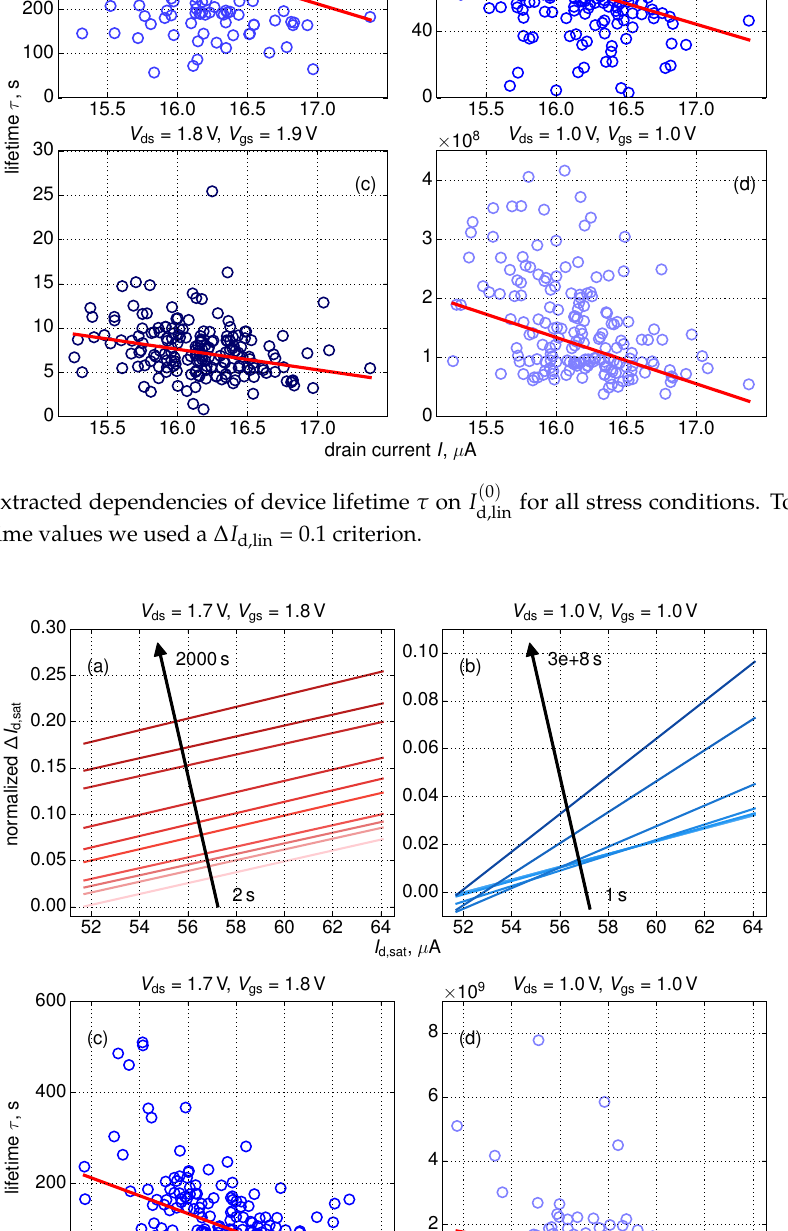
Figure 10. Extracted ∆ I d,sat ( I obtained using ∆ I d,sat traces ( c , d